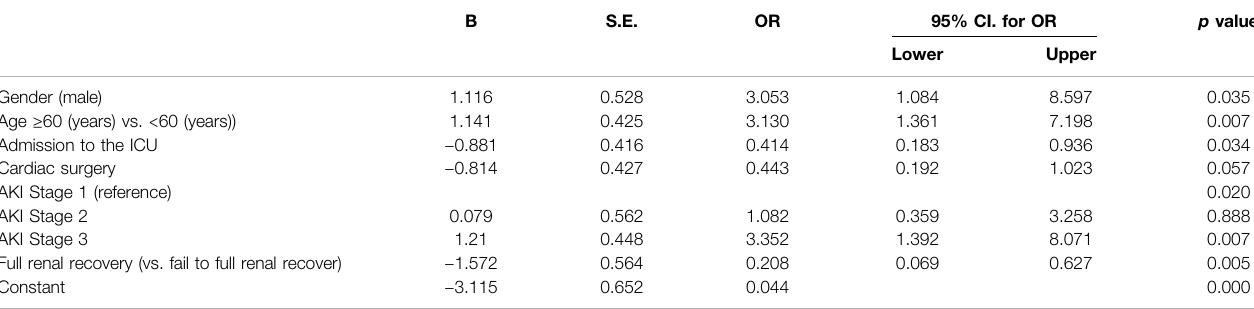
TABLE 6 | Multivariable logistic regression of factors for mortality of VA-AKI patients. B S.E. OR 95% CI. for OR p value Lower Upper